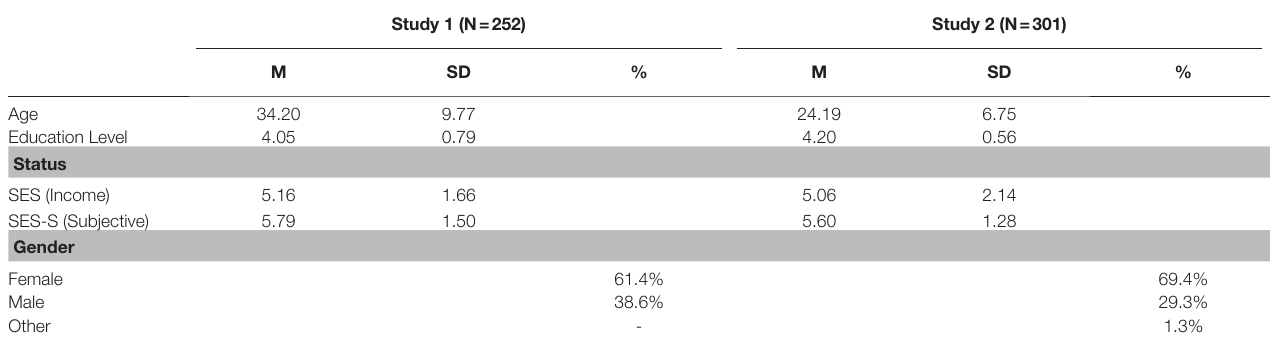
TABLE 1 | Sample’s demographic information-descriptive statistics in each